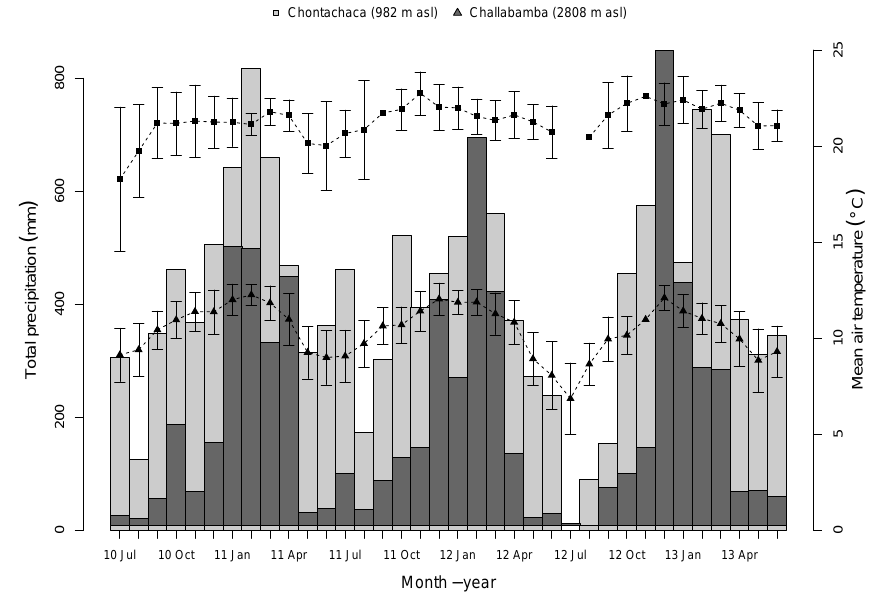
Figure 1. Total monthly precipitation and monthly mean diurnal temperature between July 2010 and June 2013 at 982ma.s.l. (Chontachaca weather station: 13 ◦ 01 (cid:48) 26 (cid:48)(cid:48) S 71 ◦ 28 (cid:48) 04 (cid:48)(cid:48) W) and 2808ma.s.l. (Challabamba weather station: 13 ◦ 13 (cid:48) 03 (cid:48)(cid:48) S 71 ◦ 38 (cid:48) 50 (cid:48)(cid:48) W). Temperature error bars are standard errors. No data were available for July 2012 at Contachaca. Plotted data were retrieved from the Servicio Nacional De Meteorogia e Hidrologia Del Peru